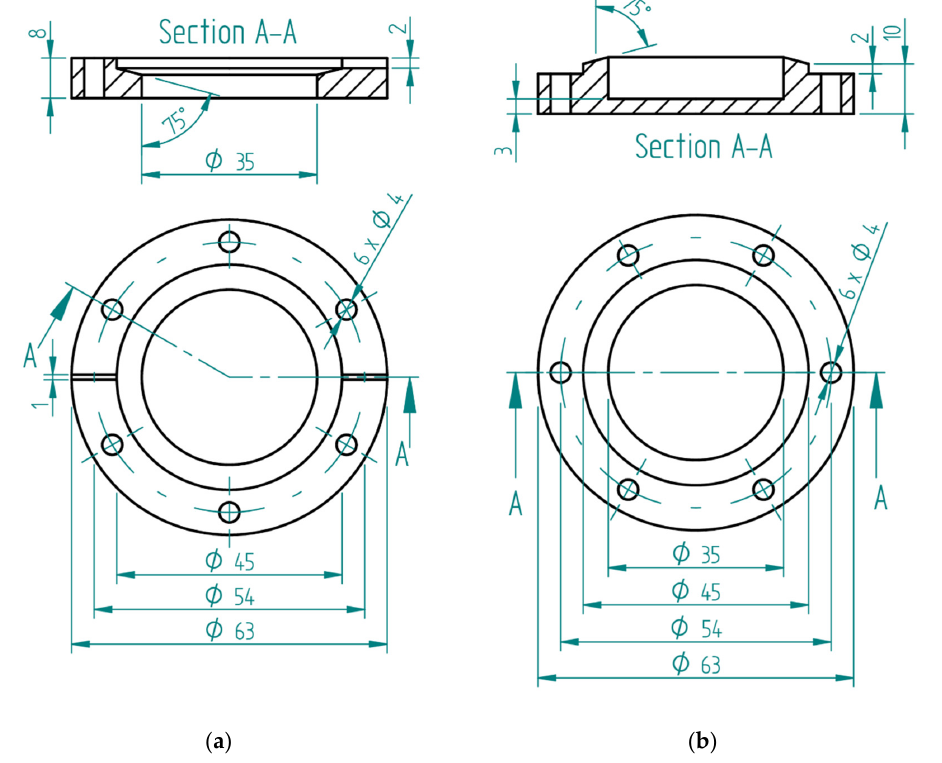
Figure A1. ( a ) Structure of the front of the diaphragm support; ( b ) Structure of the back of the diaphragm support.